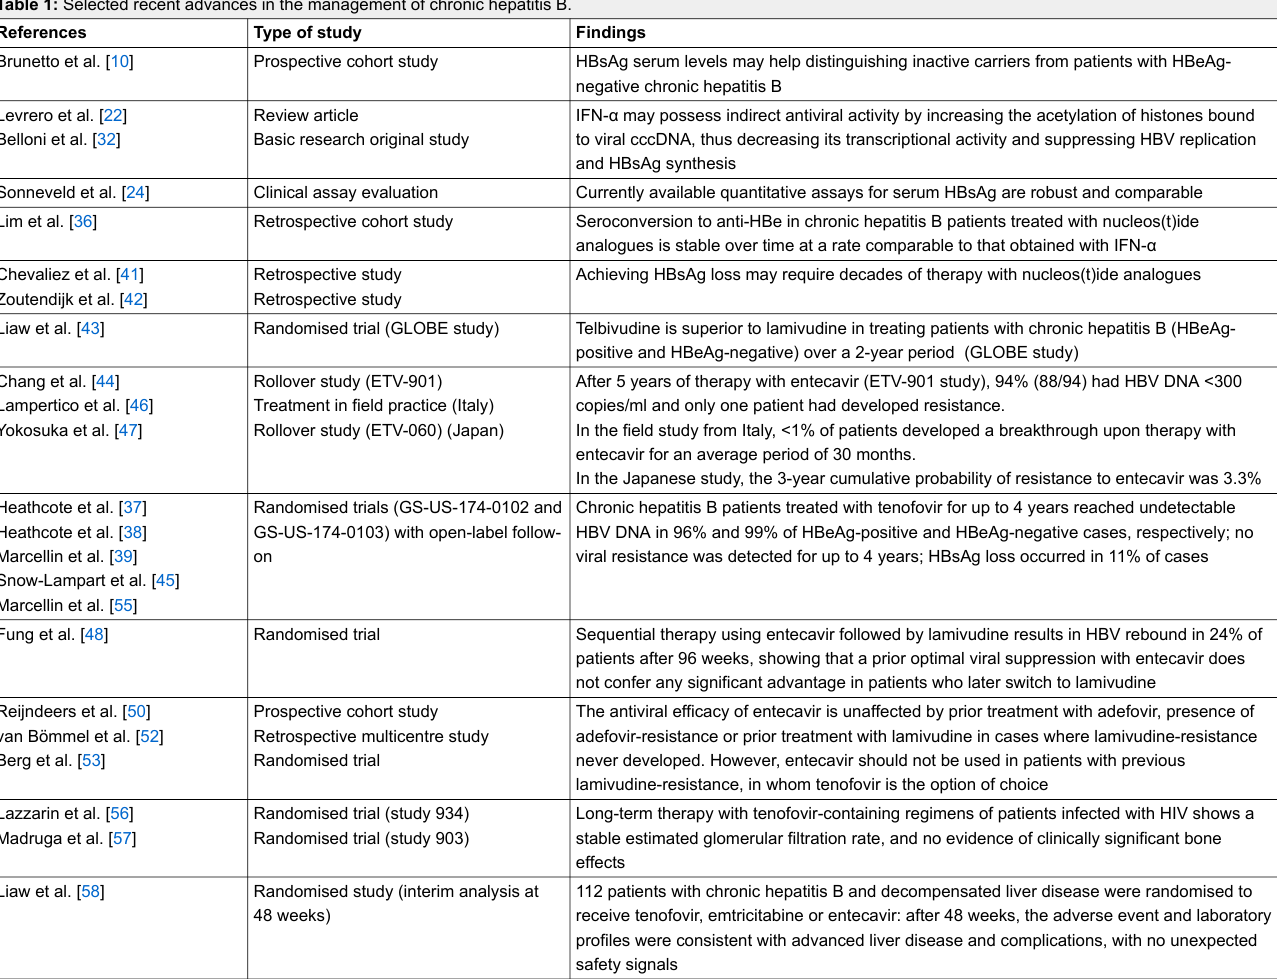
Table 1: Selected recent advances in the management of chronic hepatitis